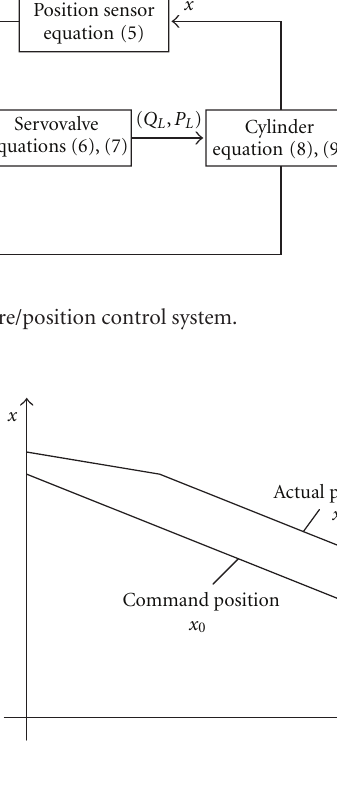
Figure 7: Illustration of the placement of